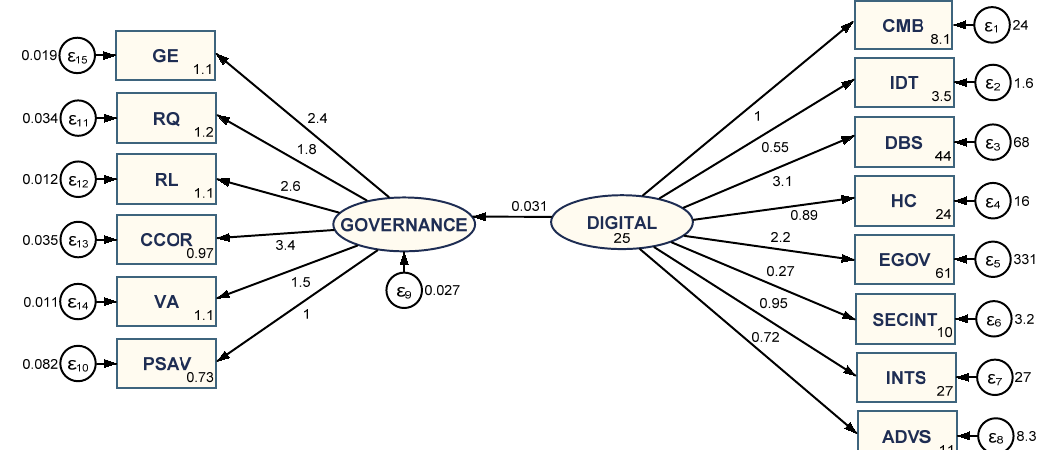
Figure 4. Results of the structural equation modelling (SEM model). Source: Authors’ research in Stata17.